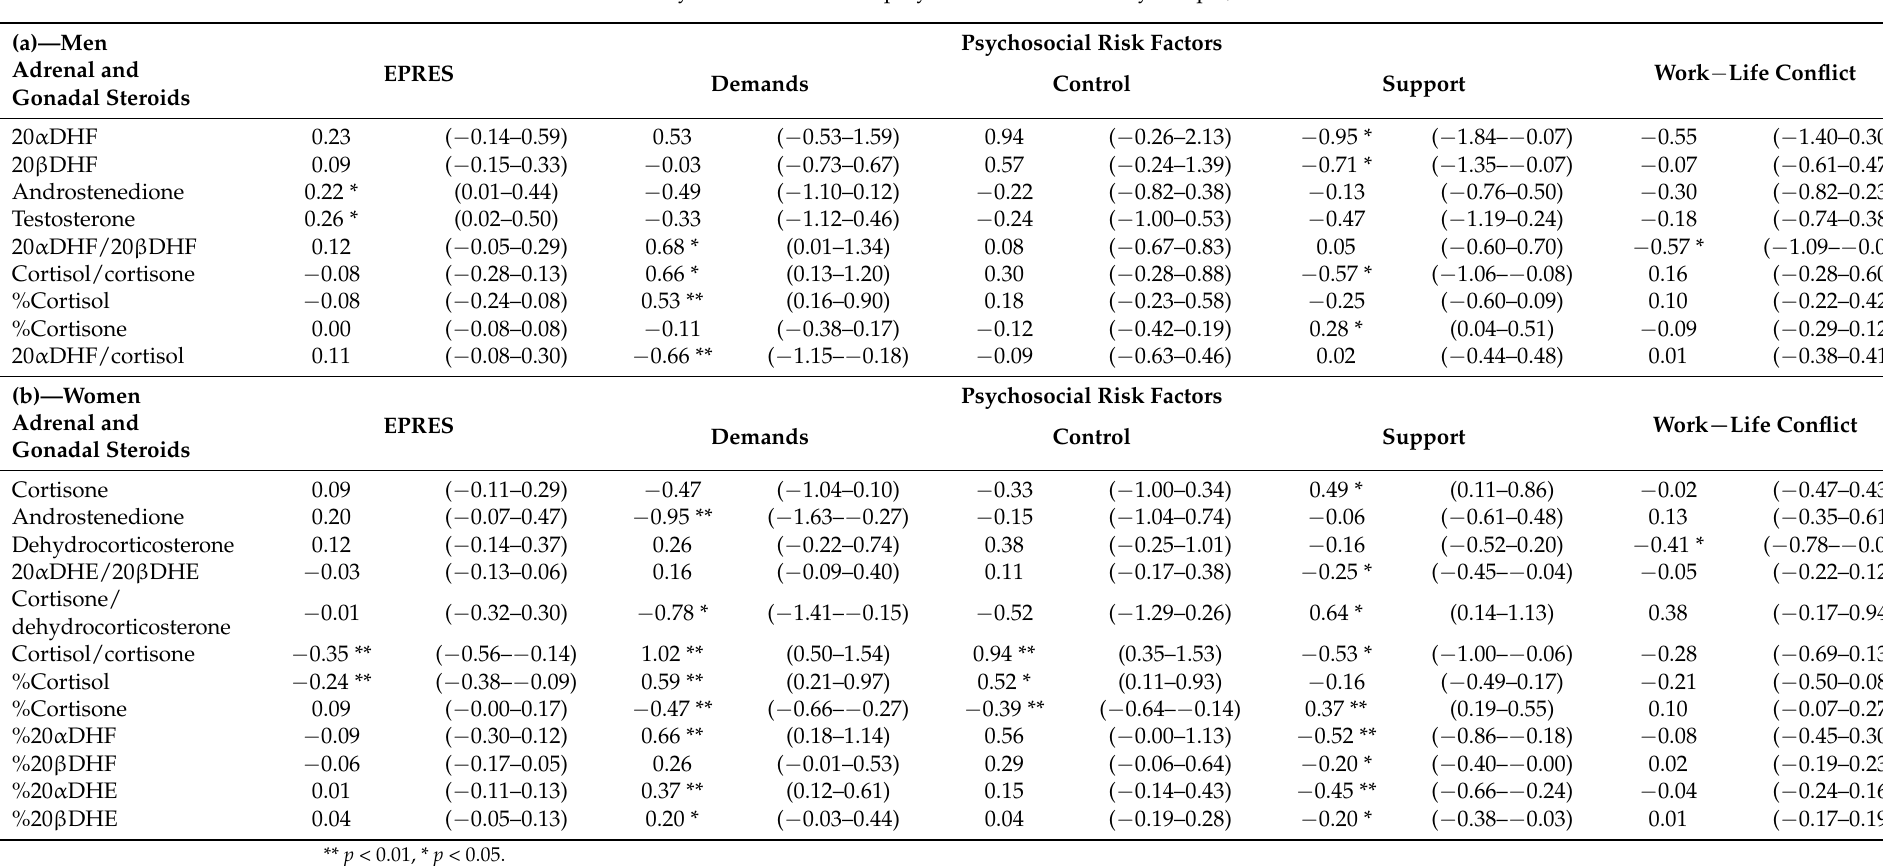
Table 2. Linear regression coefficients and 95% confidence intervals (CIs) for production of adrenal and gonadal steroids and PE and PRFs concomitantly, adjusted for control variables and stratified by sex. Precarious Employment and Stress Study sample,